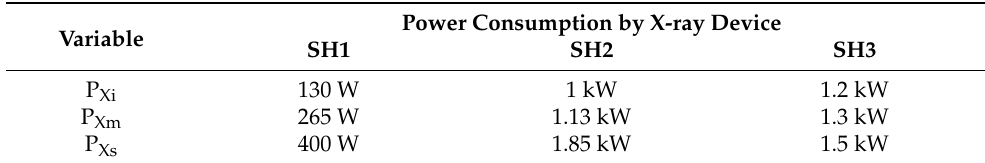
Table 2. Power consumption of X-ray equipment.